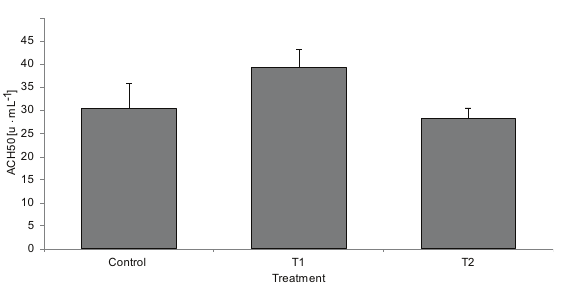
Fig. 4. Plasma lysozyme activity of tinfoil barb, Barbonymus schwanenfeldii , fed different levels of dietary probiotics (control, 0 CFU · g –1 diet; T1, 1 × 10 4 CFU · g –1 diet; T2, 1 × 10 6 CFU · g –1 diet) for 15 days; Data are presented as mean ± SE ( n = 9); No sig- nificant difference ( P > 0.05) was observed between